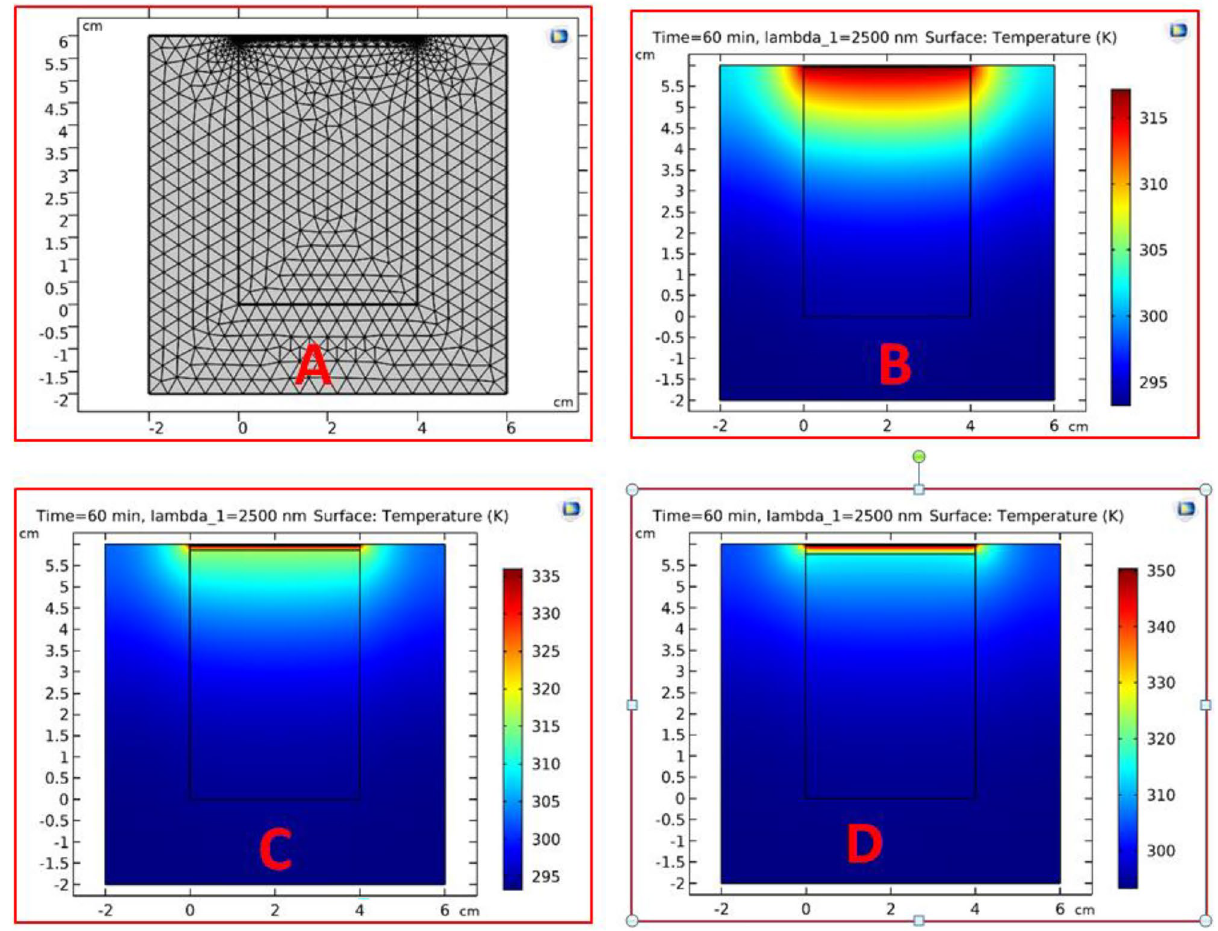
Figure 8. Schematic structure of saline water in an acrylic tank with a one-dimensional PCs of TiN/TiO2 with a thickness of 200 µ m for each of them for one period. The solar heat flux = 680 W/m 2 at one hour as shown ( A ) Meshing size is fine, ( B ) Without air gap, ( C ) With air gap equal to 1 mm, and ( D ) With air gap equal to 2 mm.